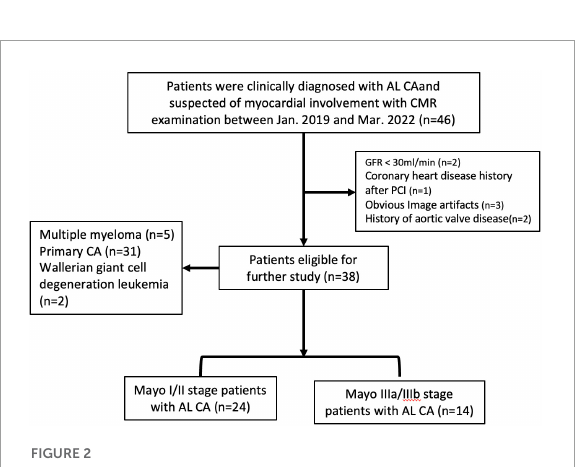
FIGURE2 The flowchart of light chain amyloidosis patient